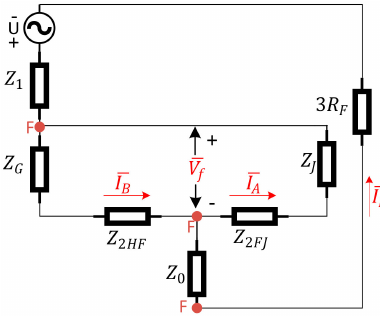
Figure 7. Simplified form of the network shown in Figure 6.